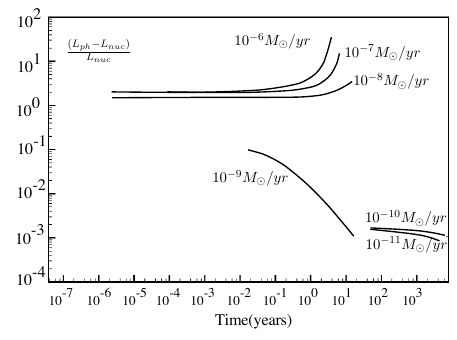
Figure 4: The time to reach thermodynamic equilib- rium.